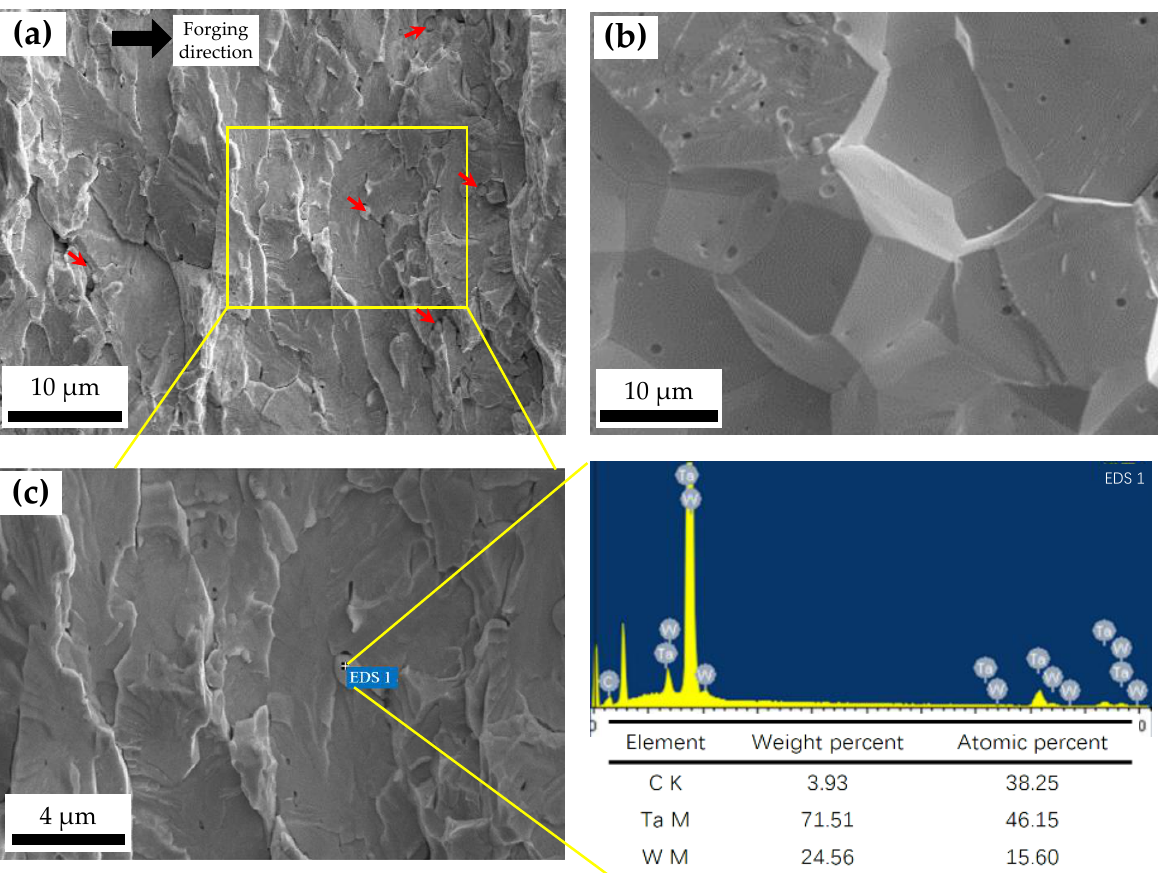
Figure 3. Tensile fracture of an as-forged WTC sample ( a ) and an as-sintered sample ( b ) at RT, black arrow shows the forging direction, and red arrows show TaC particles. ( c ) is an enlarged view of the yellow box in ( a ), it shows the TaC particle in tungsten matrix.